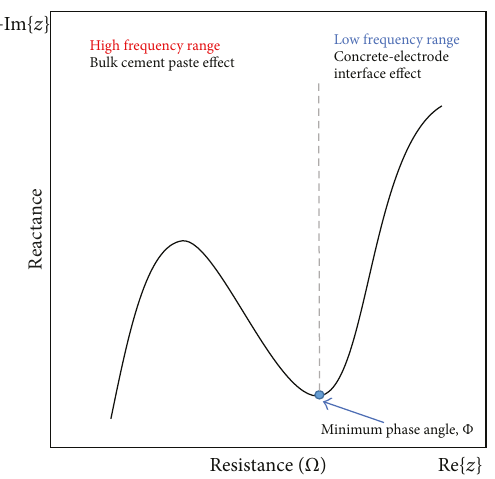
Figure 10: Schematic representation of the AC Impedance response of concrete